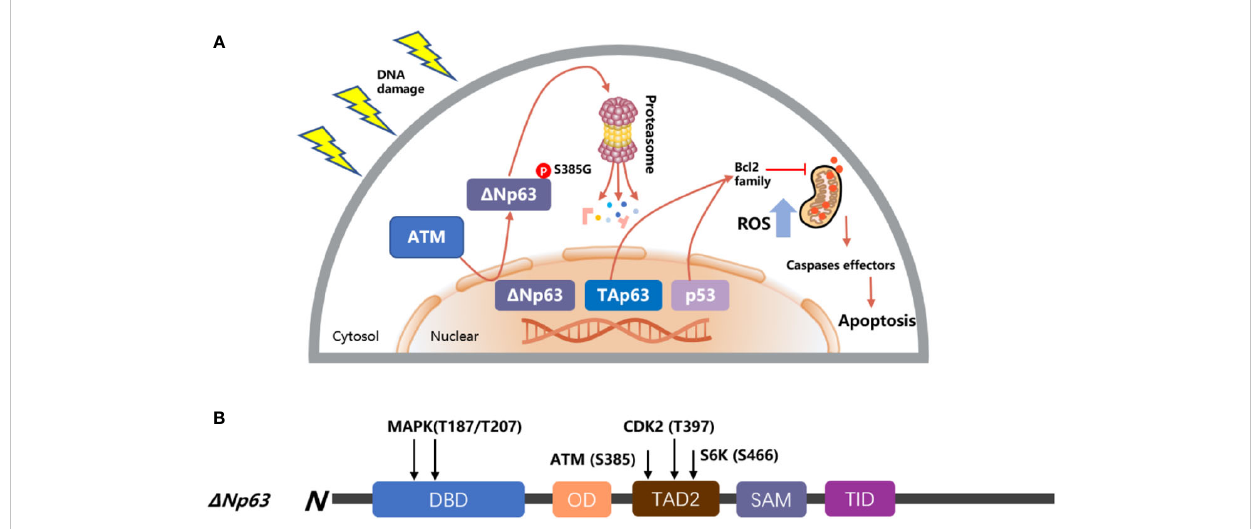
FIGURE 4 Model of p53 and p63 in response to DNA damage. (A) TAp63 and p53 induce apoptosis pathways to activate the mitochondrial cascades, and D Np63 is phosphorylated at S385G (p- D Np63 S385G ) by ATM and degraded following DNA damage. (B) The modular structure of D Np63 with putative phosphorylation sites. The arrows indicate the newly identi fi ed phosphorylation sites for MAPK (T187/T207), ATM (S385), CDK2 (T397), and p70s6K (S466) kinases (75, 105,